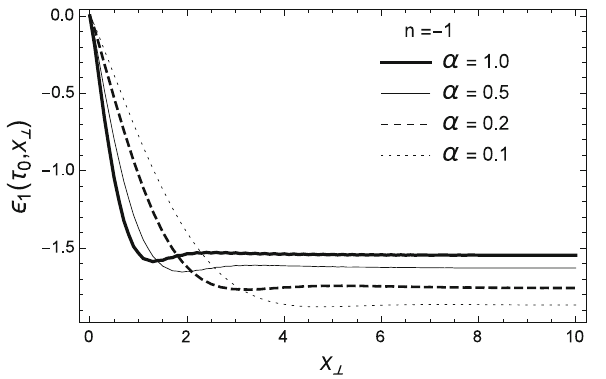
Fig. 12 A comparison between the approximated b 2 φ in Bessel series (dotted curve) and the assumed external magnetic field (solid curve) with n = − 4 / 3